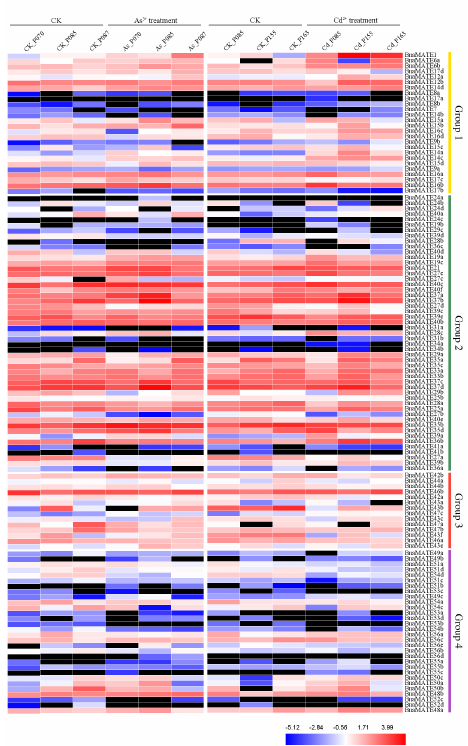
Figure 6. Expression analysis of BnaMATE family genes in di ff erent rapeseed tissues under As 3 +